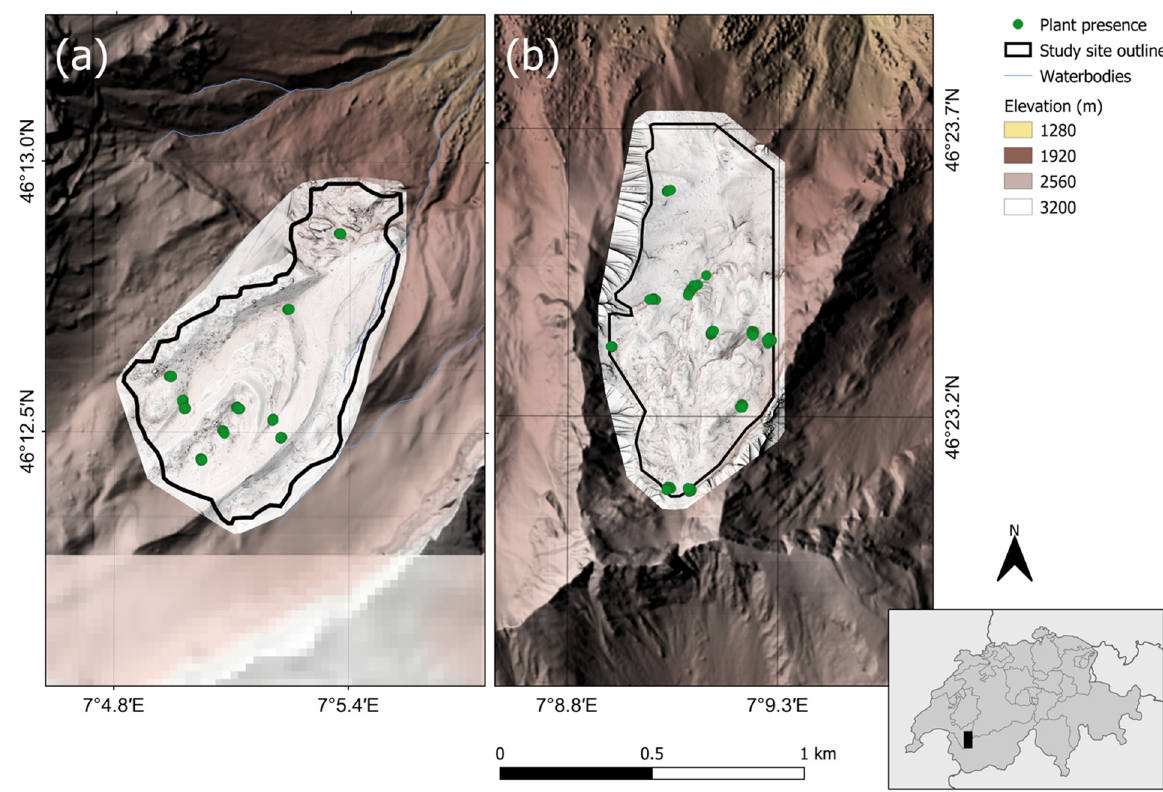
Figure 2. Location of Arabis alpina individuals (green dots) across ( a ) Martinets (n = 100 locations) and ( b ) Para (n = 146 locations) sites, where target site perimeters are outlined in black. The sky view factor (SVF) variable derived from PHOTO is shown in light colors and superimposed on hill shaded DEMs.